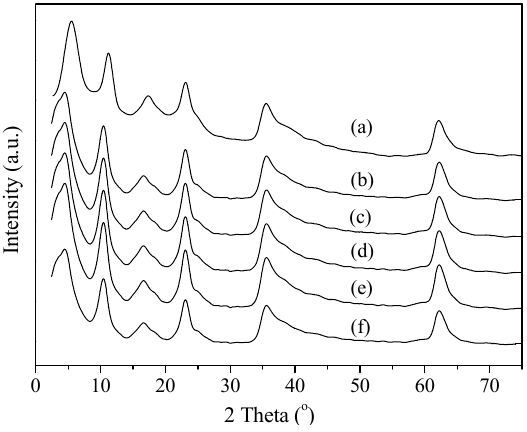
Figure 2. XRD patterns of ( a ) LDH ‐ [C 6 H 5 COO], ( b ) LDH ‐ [Cr(SO 3 ‐ salphen)], ( c ) LDH ‐ [Mn(SO 3 ‐ salphen)], ( d ) LDH ‐ [Fe(SO 3 ‐ salphen)], ( e ) LDH ‐ [Co(SO 3 ‐ salphen)], ( f ) LDH ‐ [Cu(SO 3 ‐ salphen)].